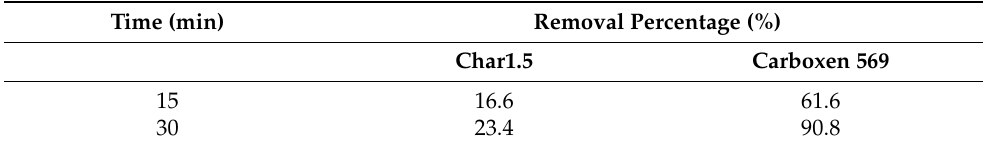
Table 6. MB removal percentage after adsorption on Char1.5 and Carboxen 569.